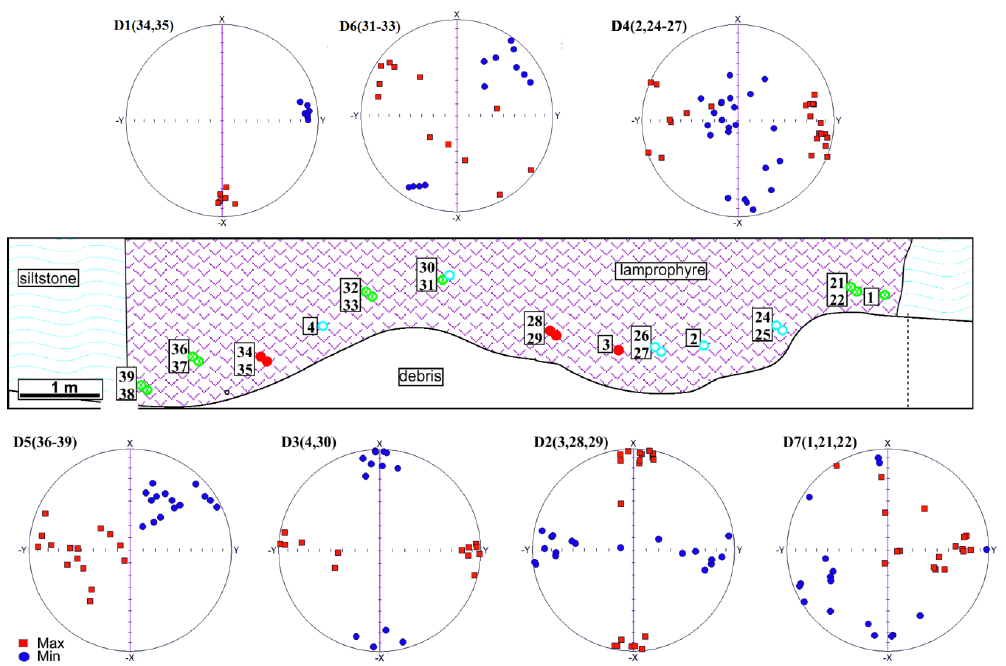
Figure 6. Positions of samples and orientations of magnetic foliation poles and magnetic lineations in homogeneous domains within the dyke. Symbols of sampling points indicate the type of magnetic fabric within the sample (solid, red — normal, open; magenta — inverse, x; green — oblique fabric). The upper left corners of the diagrams show the domain numbers (with numbers of samples creating the individual domains in brackets). Dyke coordinate system, equal-area projection on lower hemisphere.